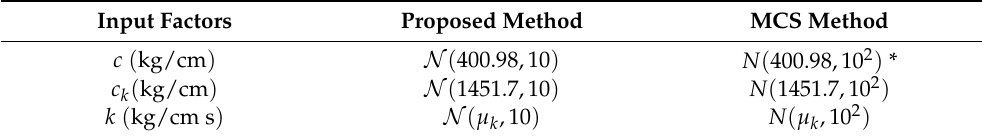
Table 2. Distribution parameters of input factors.